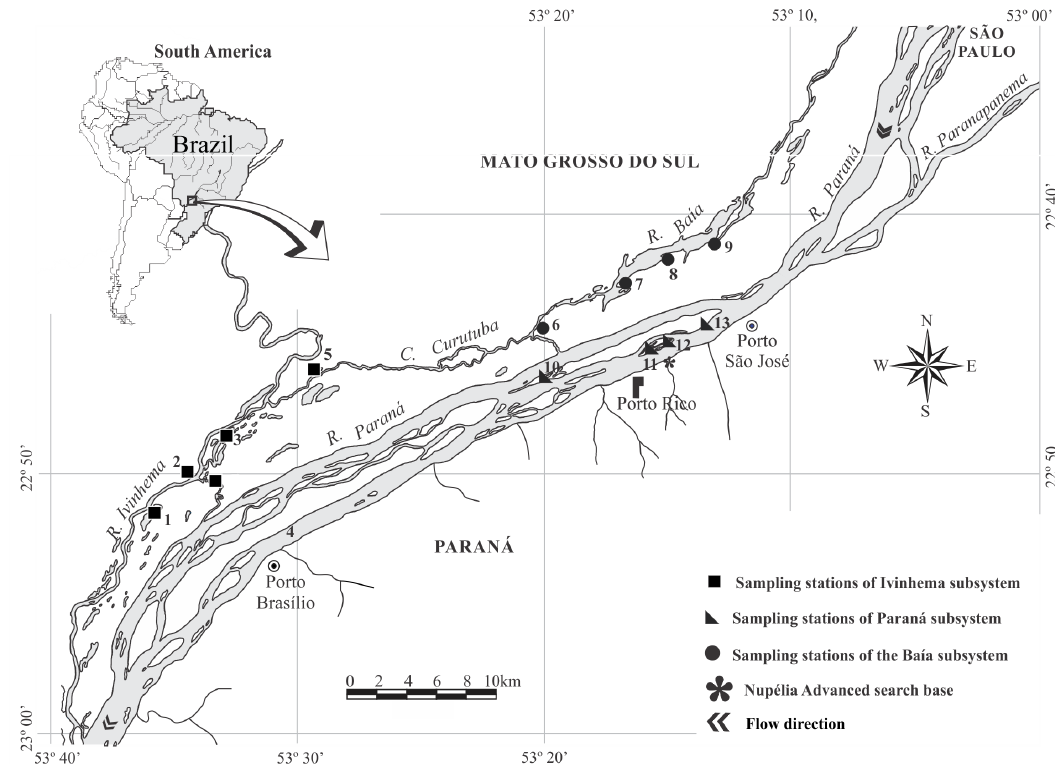
Figure 1. Map of the Upper Paraná River floodpain showing the locations of the 13 isolated floodplain lake sampled: (1) Ventura; (2) Zé do Paco; (3) Capivara; (4) Jacaré; (5) Cervo; (6) Traíra; (7) Fechada; (8) Pousada das Garças; (9) Aurélio; (10) Osmar; (11) Genipapo; (12) Clara and (13)